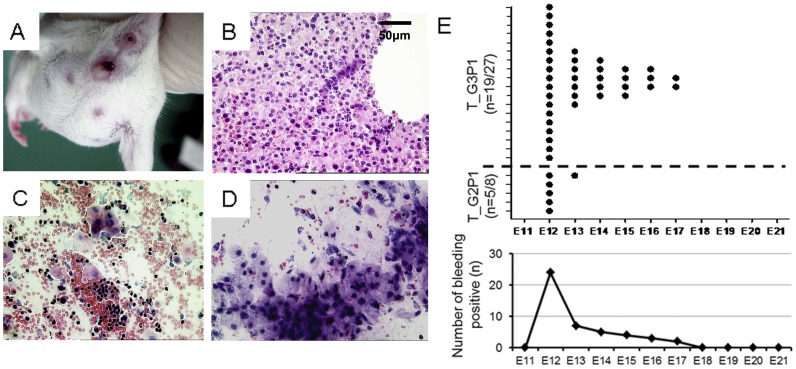
Miscarriage characteristics of subsequent pregnancies in BALB/c mice after 1 or 2 medically induced abortions.(A) Bleeding and fetal discharge from the vaginal introitus in T_G3P1 mice on day 13.5 of pregnancy. (B) The discharged blood was stained with HE. (C) Vaginal smears from the mice revealed bleeding. (D) Remnants of mesenchyme-like cells are shown. (E) Bleeding in T_G2P1 and T_G3P1 mice was observed after abortion treatment. (Scale bar, 50 µm).